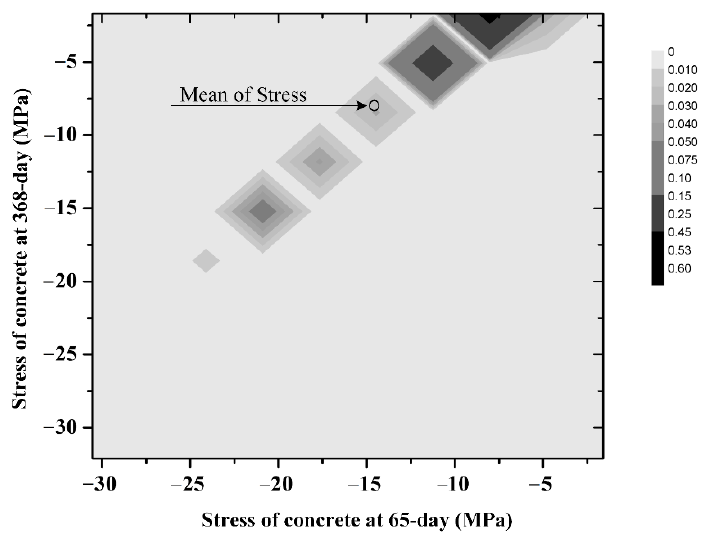
Figure 7. Counters of the joint probability distribution at the top of the 1/4 span cross-section of Span # 2.